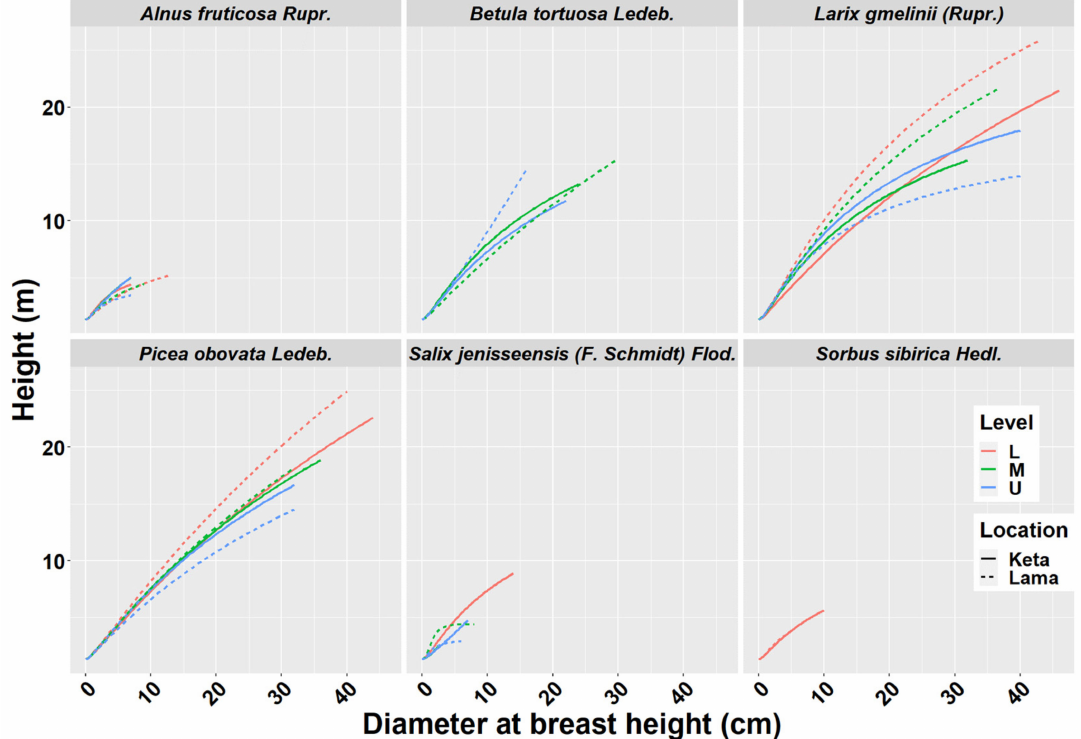
Figure 1. Height-diameter models of six tree species at two locations of Keta and Lama. Statistical parameters of models are presented in Table 1. Level—L—lower elevational zone, M—middle elevational zone, U—upper elevational